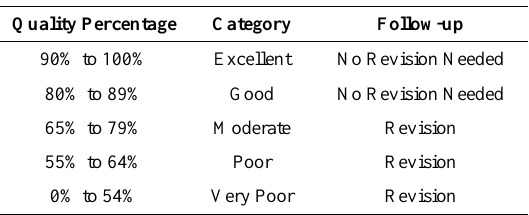
Table 1. Five Scale Categorization